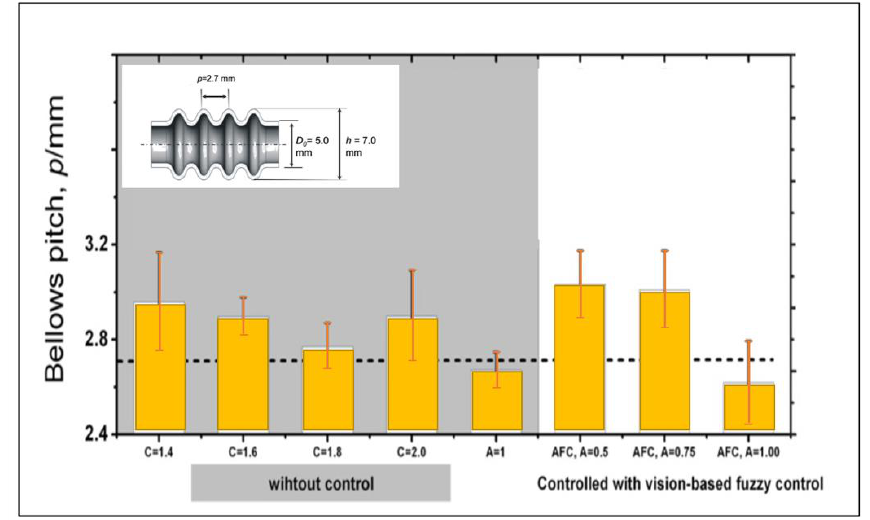
Figure 24. Evaluation of the bellows pitches under di ff erent bellows targets.